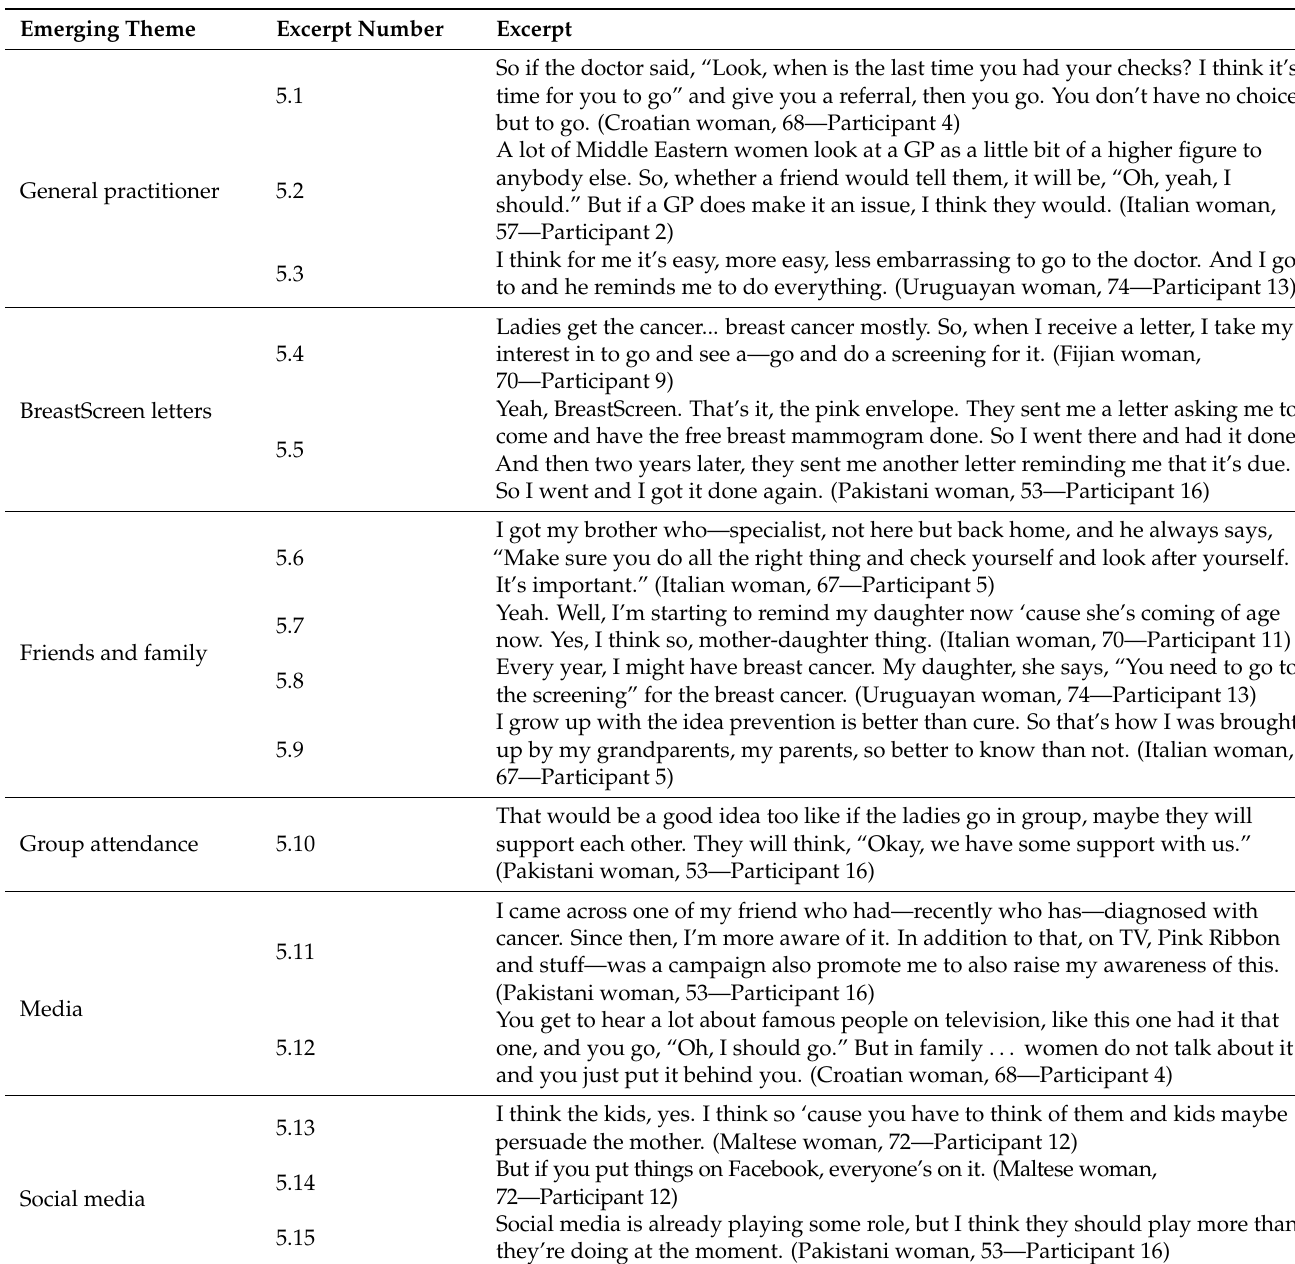
Table 5. Patient-reported general facilitators to